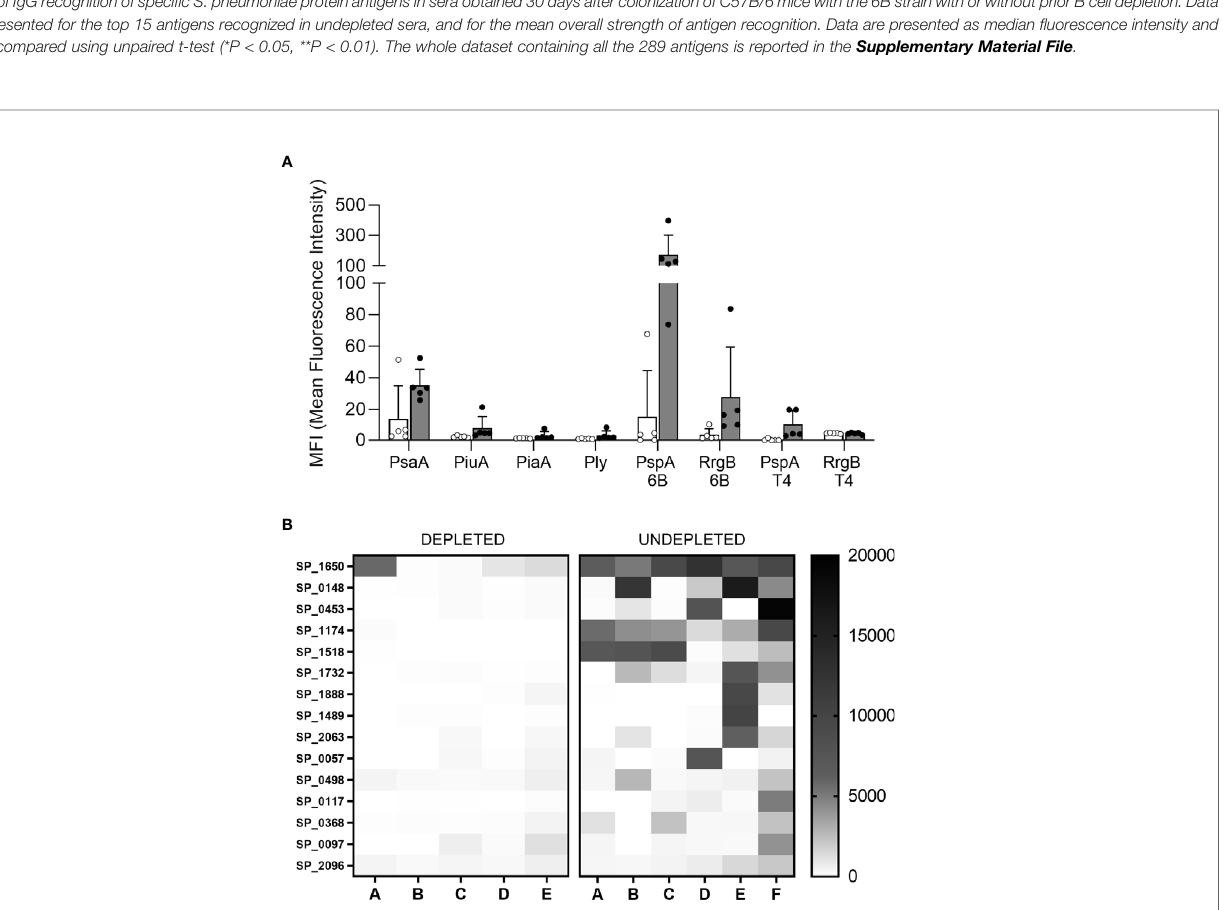
FIGURE 6 | Antigen speci fi c response. (A) Meso Scale Discovery (MSD) has been used to measure the speci fi c IgG response to 6 pneumococcal antigens in the sera of depleted (white) and not depleted (gray fi lled) C57Bl/6 mice colonized with S. pneumoniae 6B strain. Error bars indicate standard deviations, each point represents individual mice. (B) A protein array containing 289 conserved pneumococcal antigens has been also probed with the individual mice sera, the IgG level against the top 15 antigens is showed for each mouse of the depleted (left) and undepleted (right) groups. Level of recognition measured in median fl uorescence intensity goes from minimum = 0 (white) to maximum = 20000 (black) and it is shown in boxes that represent the average values of each single antigen for individual